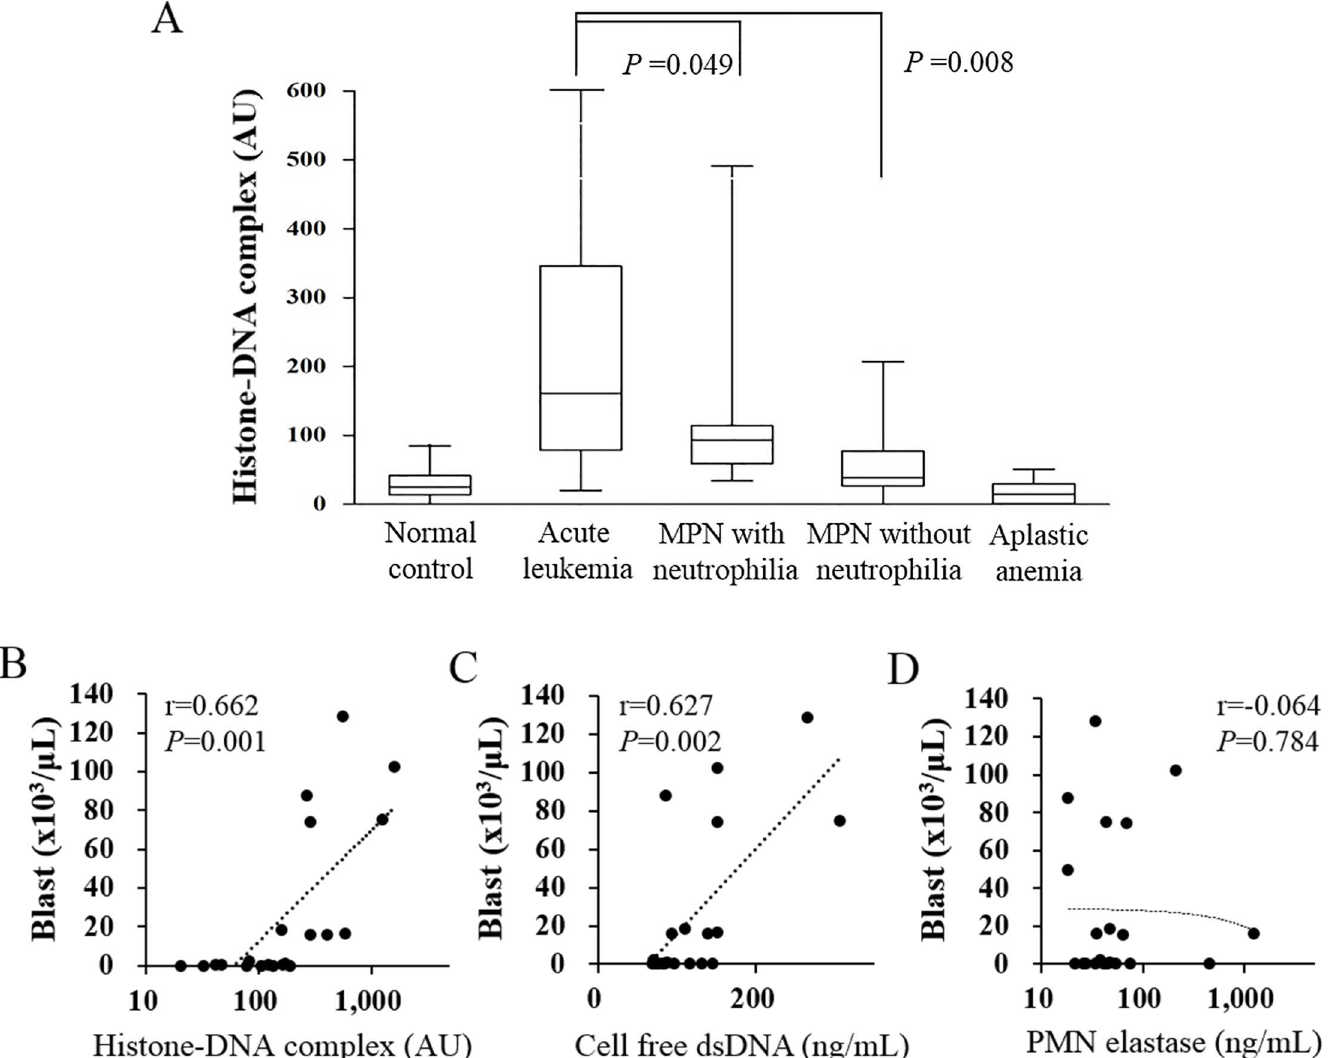
Fig 1. Circulating histone levels are increased in patients with acute leukemia and correlate with peripheral blast counts. (A) Circulating levels of the histone–DNAcomplex in normal controls (n = 40) and in patients with acute leukemia(n = 21), myeloproliferative neoplasms (MPN) with neutrophilia (n = 13), MPN without neutrophilia(n = 32), and aplastic anemia (n = 14). (B, C, D) Correlationof peripheral blast count with circulatinglevels of histone–DNA complex, cell-free double-stranded DNA (dsDNA), and neutrophilelastase in acute